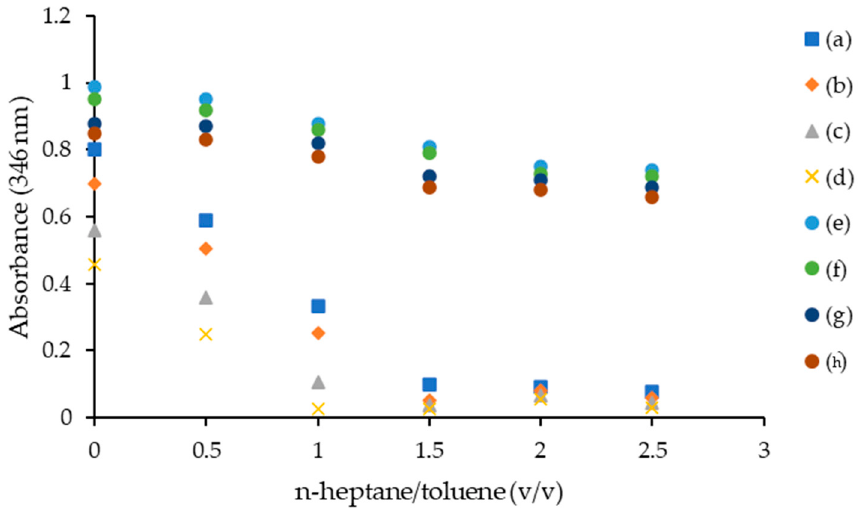
Figure 4. Asphaltene onset precipitation. (a) [C 6 C 1 Pip] 2 [LS], (b) [C 8 C 1 Pip] 2 [LS], (c) [C 12 C1Pip] 2 [LS], (d) [C 16 C 1 Pip] 2 [LS], (e) [C 6 C 1 Pip][Cl], (f) [C 8 C 1 Pip][Cl], (g) [C 12 C 1 Pip][Cl], (h) [C 16 C 1 Pip][Cl].